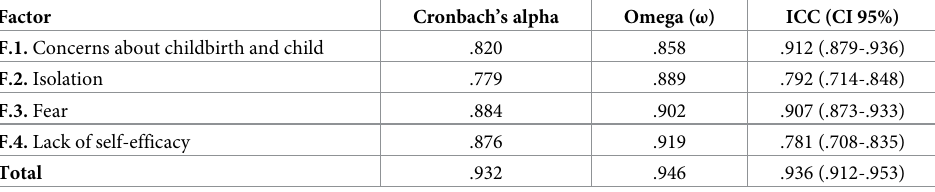
Table 5. W-DEQ-B-Sp Cronbach’s alpha coefficient, omega coefficient and ICC test-retest (n =